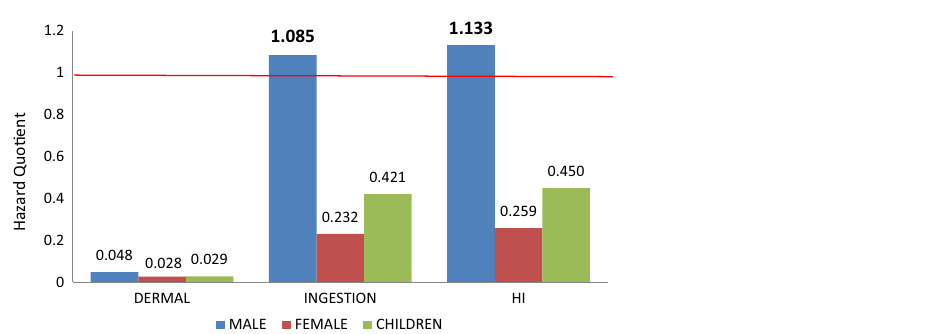
Figure 4. Non-carcinogenic health risks indices of metals.